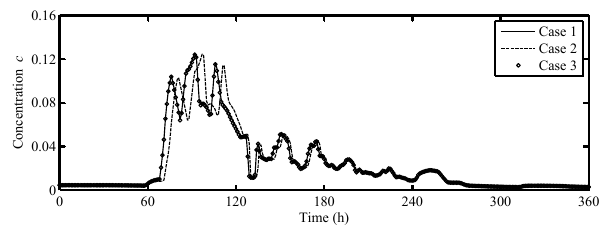
Fig. 2. Sediment concentrations at the Huayuankou station ( x = 125.8km).